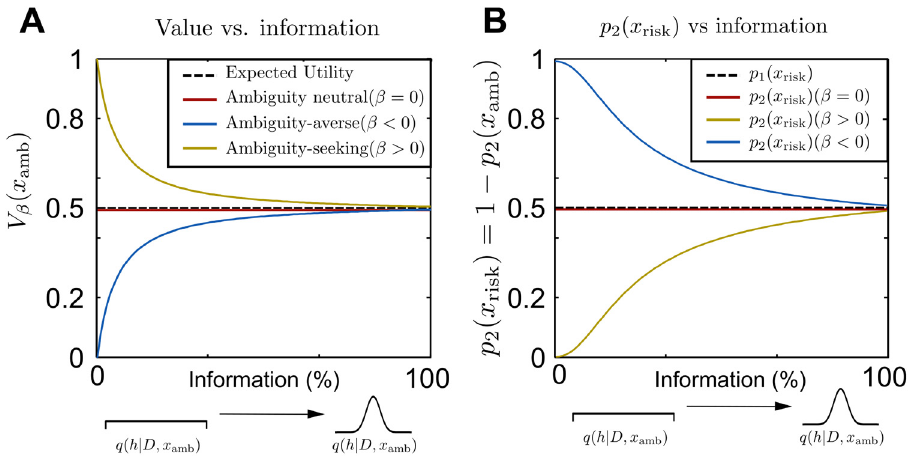
Fig 1. Illustration of model predictions. Predictions for probe trials where the risky urn (with equal composition of blue and red balls) has the same expected utility as the ambiguous urn — the number of observed red balls is equal to the number of observed blue balls. In panel A we show the value of Eq (3) assigned to an ambiguous option depending on the ambiguity attitude β and on the available information. In the case of the urn, information is quantified with the number of observations. The more information becomes available the more concentrated is the Bayesian posterior q ( h | D , x ), so a high number of observed balls reflect a peaked posterior. We show in yellow line the value of the ambiguous option V β ( x amb ) according to Eq ¼ 0 : 5 (indicated by the (3) for positive β (optimistic) being higher or equal than the expected utility value E q j x risk dashed line). In blue we show that for negative β (pessimistic) the value V β is always lower or equal than the expected utility value. The value V β converges to the expected-utility value if the decision-maker is ambiguity- neutral (red line for β ! 0) or in the absence of ambiguity when the posterior becomes a delta function q ( h | D , x ) = δ ( h − h * ). In panel B we show the predicted choice probability in probe trials according to Eq (4) for different β . Translating the value into a choice probability requires an additional parameter α that regulates the level of stochasticity like in a soft-max choice rule. For example, we show in yellow for a particular α > 0 how the probability of choosing the risky option is modulated by the information available. The dashed line indicates the perfectly rational expected utility maximizer that is indifferent between the risky and the ambiguous option in the probe